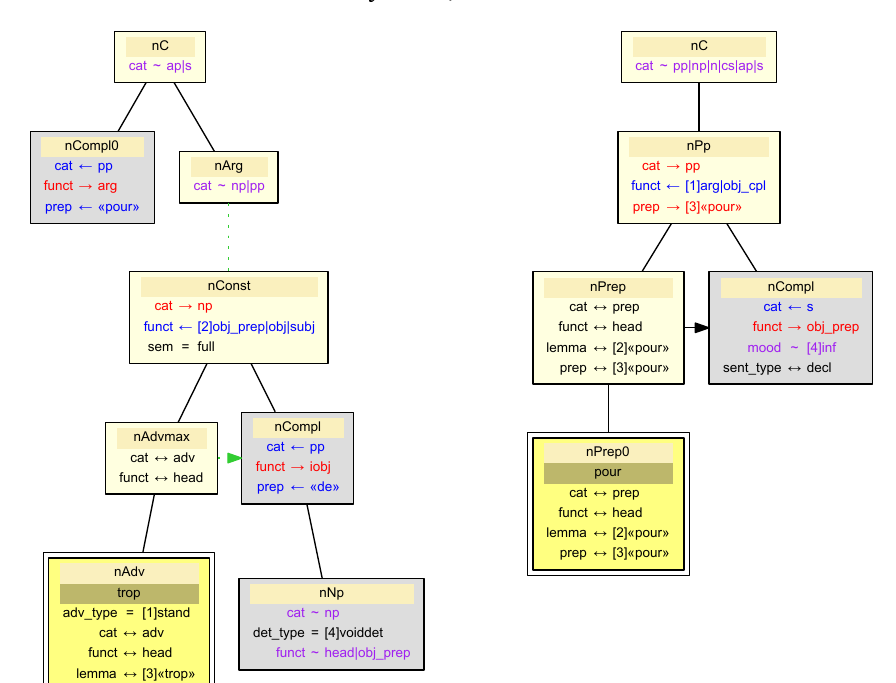
Figure 19: EPTDs anchored by trop and pour for the parsing of Sentence (19)